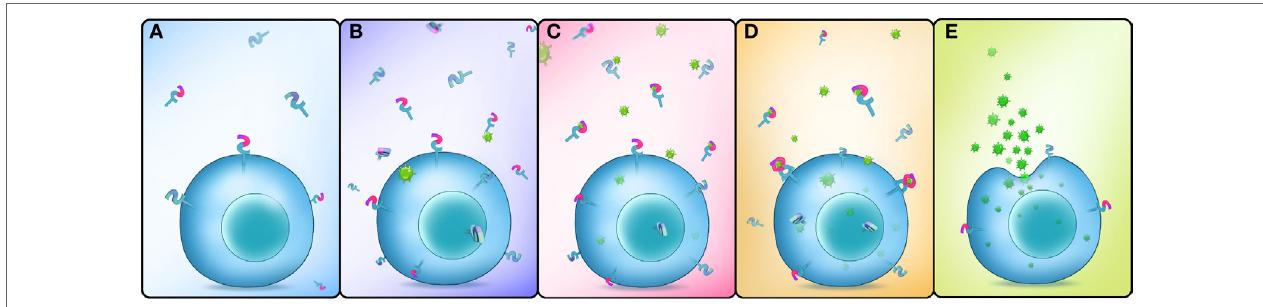
FigUre 9 | Schematic representation of Dscam-regulated pathogen-specific phagocytosis. (a) Lower concentrations of membrane-bound and soluble Es Dscam in normal hemocytes and cell-free hemolymph. (B) The expression of membrane-bound and soluble Es Dscam (including bacteria-specific induced and non-specific induced Es Dscam isoforms) is highly induced after bacterial infection. (c) Bacteria-specific induced soluble Es Dscam isoforms bind with high affinity to the original bacteria, while the other soluble isoforms show weak or no binding with the bacteria. (D) Bacteria-specific binding soluble Es Dscam isoforms interact with the membrane-bound Es Dscam containing the same extracellular region. (e) Es Dscam regulates pathogen-specific phagocytosis in crab hemocyte.